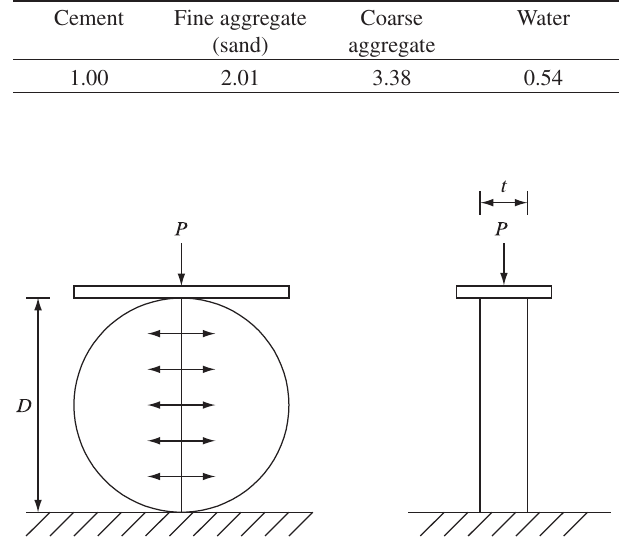
Figure 4. Schematics of the Brazilian tensile strength test.